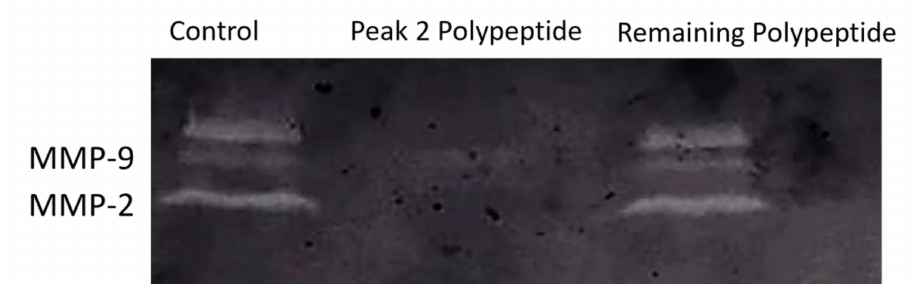
Figure 7. Peak 2 polypeptide inhibits gelatinolytic activity of MMP-2 and MMP-9. Representative image of the zymographic profiles of MMP-9 and MMP-2 activity in the presence of different peptide fractions present in fermented cheese whey. MMP- 9 and MMP-2 proteolytic activities were detected in HT29 extracellular media after 48-hour exposure to 100 µ g